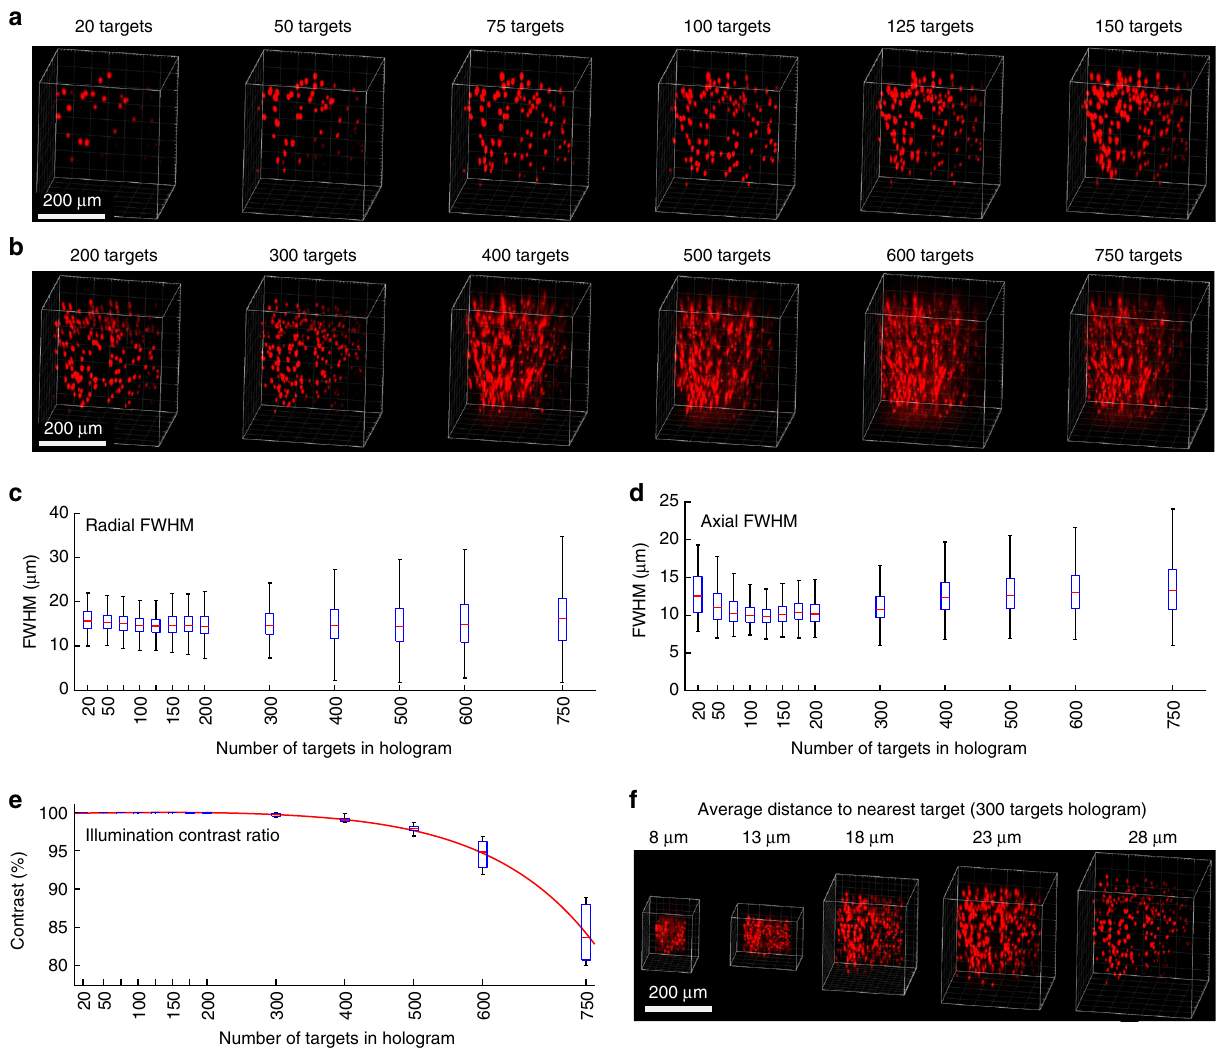
Fig. 8 Spatial resolution with simultaneous targets throughout a large volume. a − b Example 3D renderings from tomographic images of two-photon absorption from single-shot holograms targeting increasing numbers of randomly distributed spots. The FWHMs of the two-photon response was computed for each target, c radially, and d axially. Results show that spatial resolution and axial con fi nement are not signi fi cantly degraded by increasing the number of simultaneous targets in any given hologram. e The contrast ratio of the holograms was quanti fi ed as a function of the number of targets, and shows that contrast, rather than resolution determines the total number of targets that can be photostimulated in a single hologram. f 3D recordings of various scaling of the same point cloud were made to evaluate density as a possible factor affecting spatial resolution (error bars correspond to range, red line is